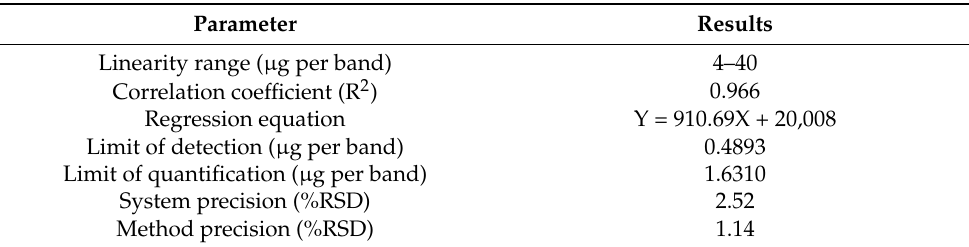
Table 3. Validation parameters of the HPTLC method for the determination of methyl gallate scanned at λ = 254